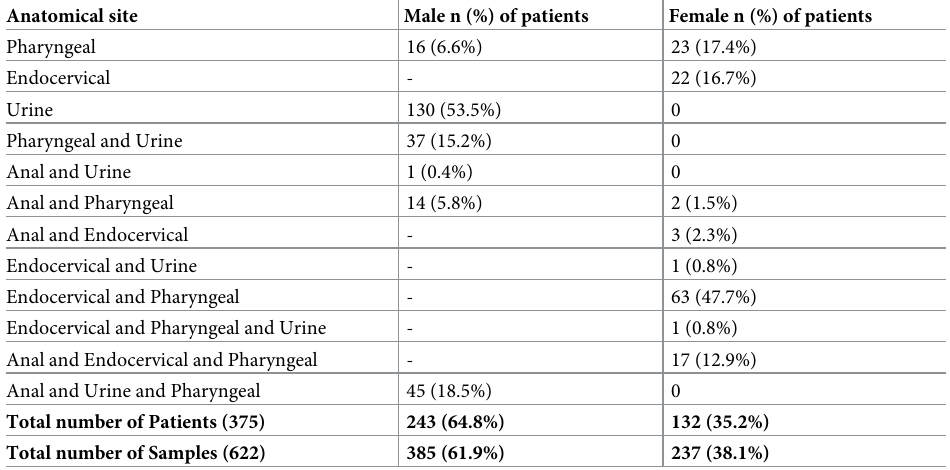
Table 1. Distribution of the collected